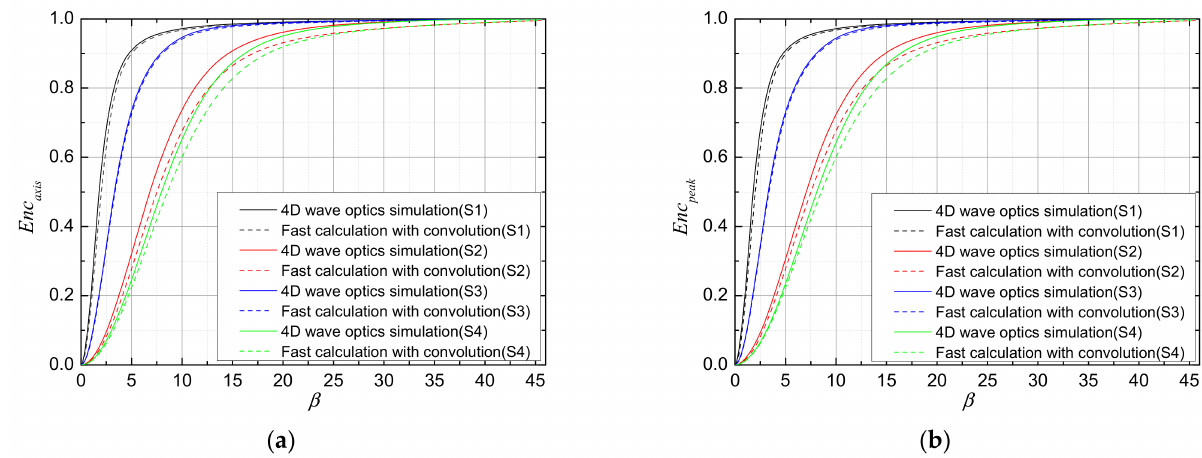
Figure 7. The change curve comparison between the fast calculation results and 4D wave optics simulation results of ( a ) Enc axis and ( b ) Enc peak with facula expansion multiple β under S1, S2, S3, and S4 scenarios.